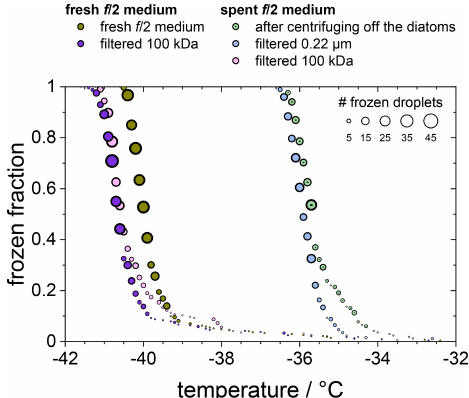
Figure 5. Frozen fraction of differently treated f/ 2 nutria media as a function of temperature. The olive and purple circles belong to a fresh f/ 2 medium that is untreated (olive) or had been filtered using a 100kDa filter (purple). The green, blue, and pink circles belong to the untreated, 0.22µm filtered, and 100kDa filtered spent medium in which the F. cylindrus diatoms had grown before they were centrifuged and separated from the